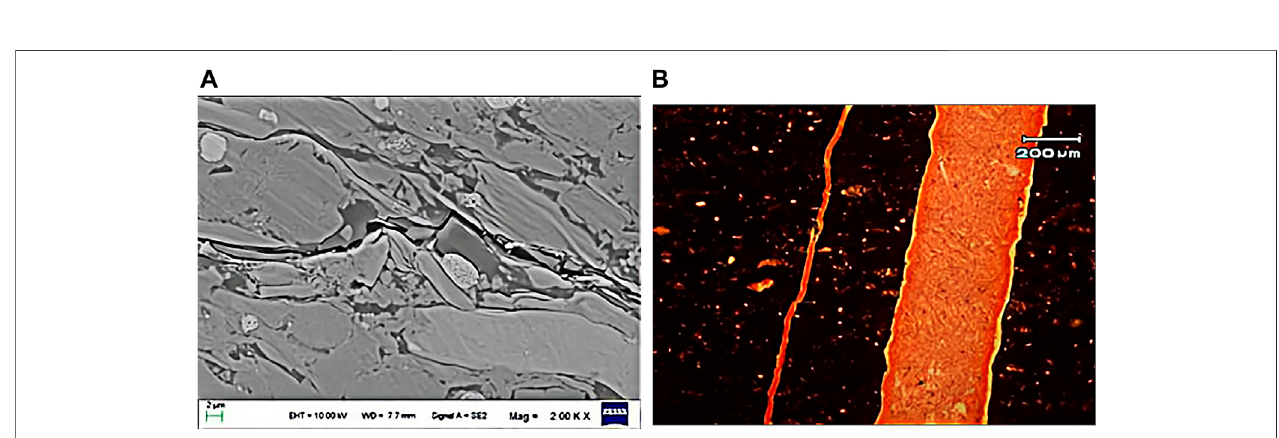
FIGURE10| CharacteristicsofmicrofracturesinlateYanshanianperiod(Yitan1well). (A) 3,498 m,L111,fractures,mineralparticlesin fl uencefracturemorphology; (B) 3,495.7 m, L112, Cracks, calcite fi lling.